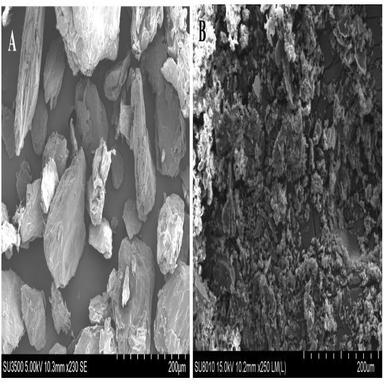
SEM images (A) Before modification (B) After modification.